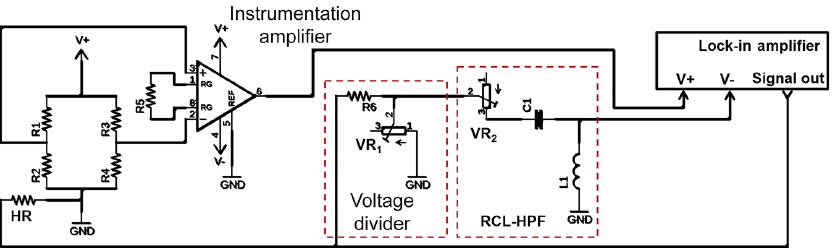
Figure 6. Setup of phase characteristic optimization by reference-signal subtraction consisting of a voltage divider and an RCL-HPF circuit.